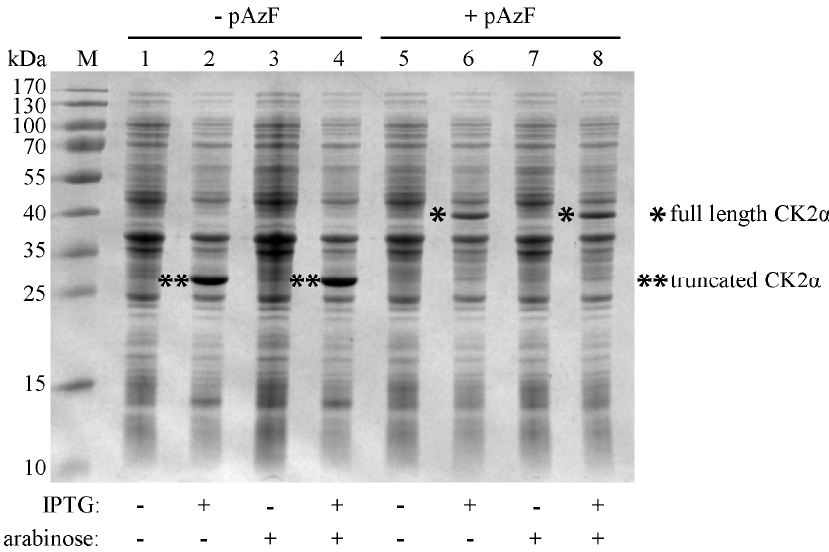
Figure 3. SDS-PAGE analysis of gene expression and incorporation of pAzF into CK2 α . The addition or the omission of the unnatural amino acid pAzF, the inducers IPTG and arabinose to E. coli BL21(DE3) cells with the plasmids CK2 α Y239Stop and pEVOL-pAzF, expressing the mutated CK2 α (IPTG) and the amber suppressor tRNA (constitutive)/aminoacyl-tRNA synthetase (constitutive/arabinose), were proven in a volume of 1 mL minimal medium for each case. Cells were boiled for 20 min at 95 °C and protein lysates were separated on 10% acrylamide. The apparent molecular mass of the marker proteins is shown in lane M. Full-length CK2 α (40 kDa) could be synthesized in lane 6 and 8, i.e., when all components were present. Because of the stop codon UAG and the lack of pAzF, the truncated CK2 α (28 kDa) appeared in lane 2 and 4.